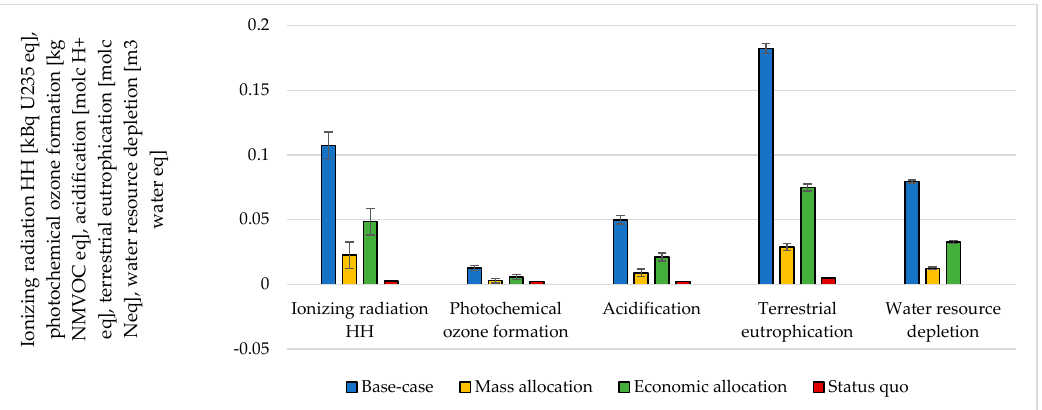
Figure 7. Ionizing radiation, photochemical ozone formation, acidification, terrestrial eutrophication, and water depletion assessment for 1 kg SNG production under different MU methodologies: base-case, mass allocation, economic allocation, and status quo.